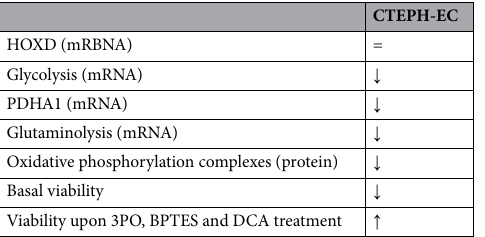
Table 2. Summary of the most relevant findings of CTEPH-EC in comparison with